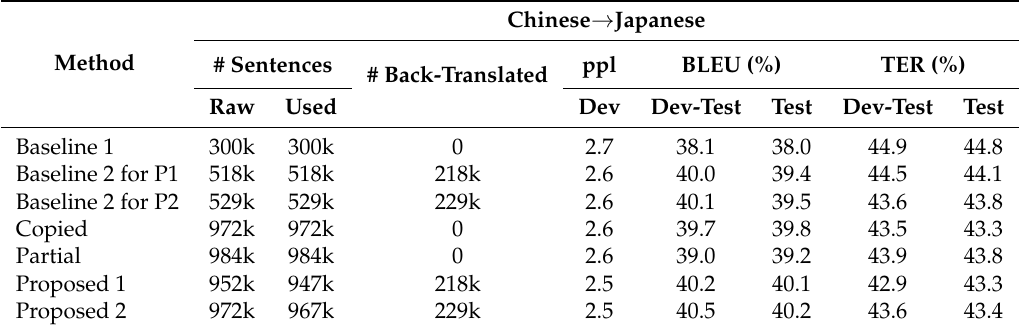
Table 5. Experiment results of Chinese → Japanese MT with 300k training data. “ppl” denotes perplexity. “Dev” denotes development data. “Dev-test” denotes development-test